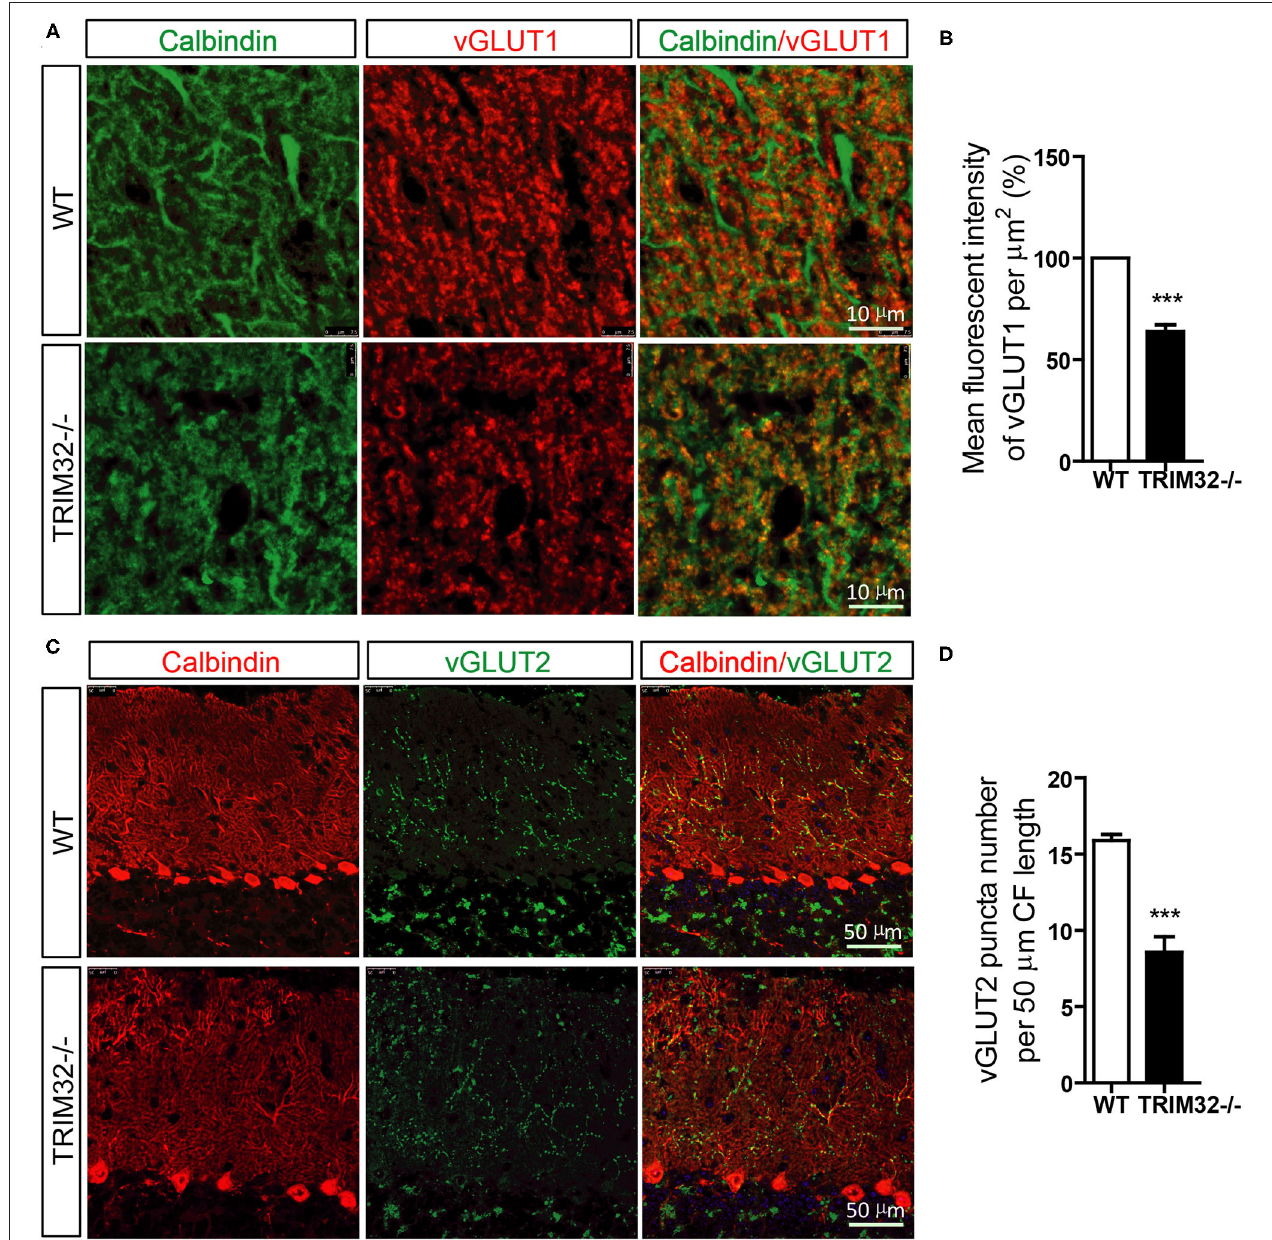
FIGURE 6 | The numbers of PFs-PCs and CFs-PCs were reduced in the TRIM32 − / – cerebellum. (A) PFs-PCs and PCs of the cerebellum were stained with antibodies against vGlut1 and calbindin. (B) Mean fluorescence intensity of vGlut1 in TRIM32 − / – mice and WT mice. (C) CFs-PCs and PCs of the cerebellum were immunostained with antibodies against vGlut2 and calbindin. (D) Quantification of vGlut2-positive puncta in TRIM32 − / – mice and WT mice. Scale bar = 10 µ m (A) , 50 µ m (C) . Data are presented as mean ± SEM. n = 5 mice/genotype. *** p < 0.001.